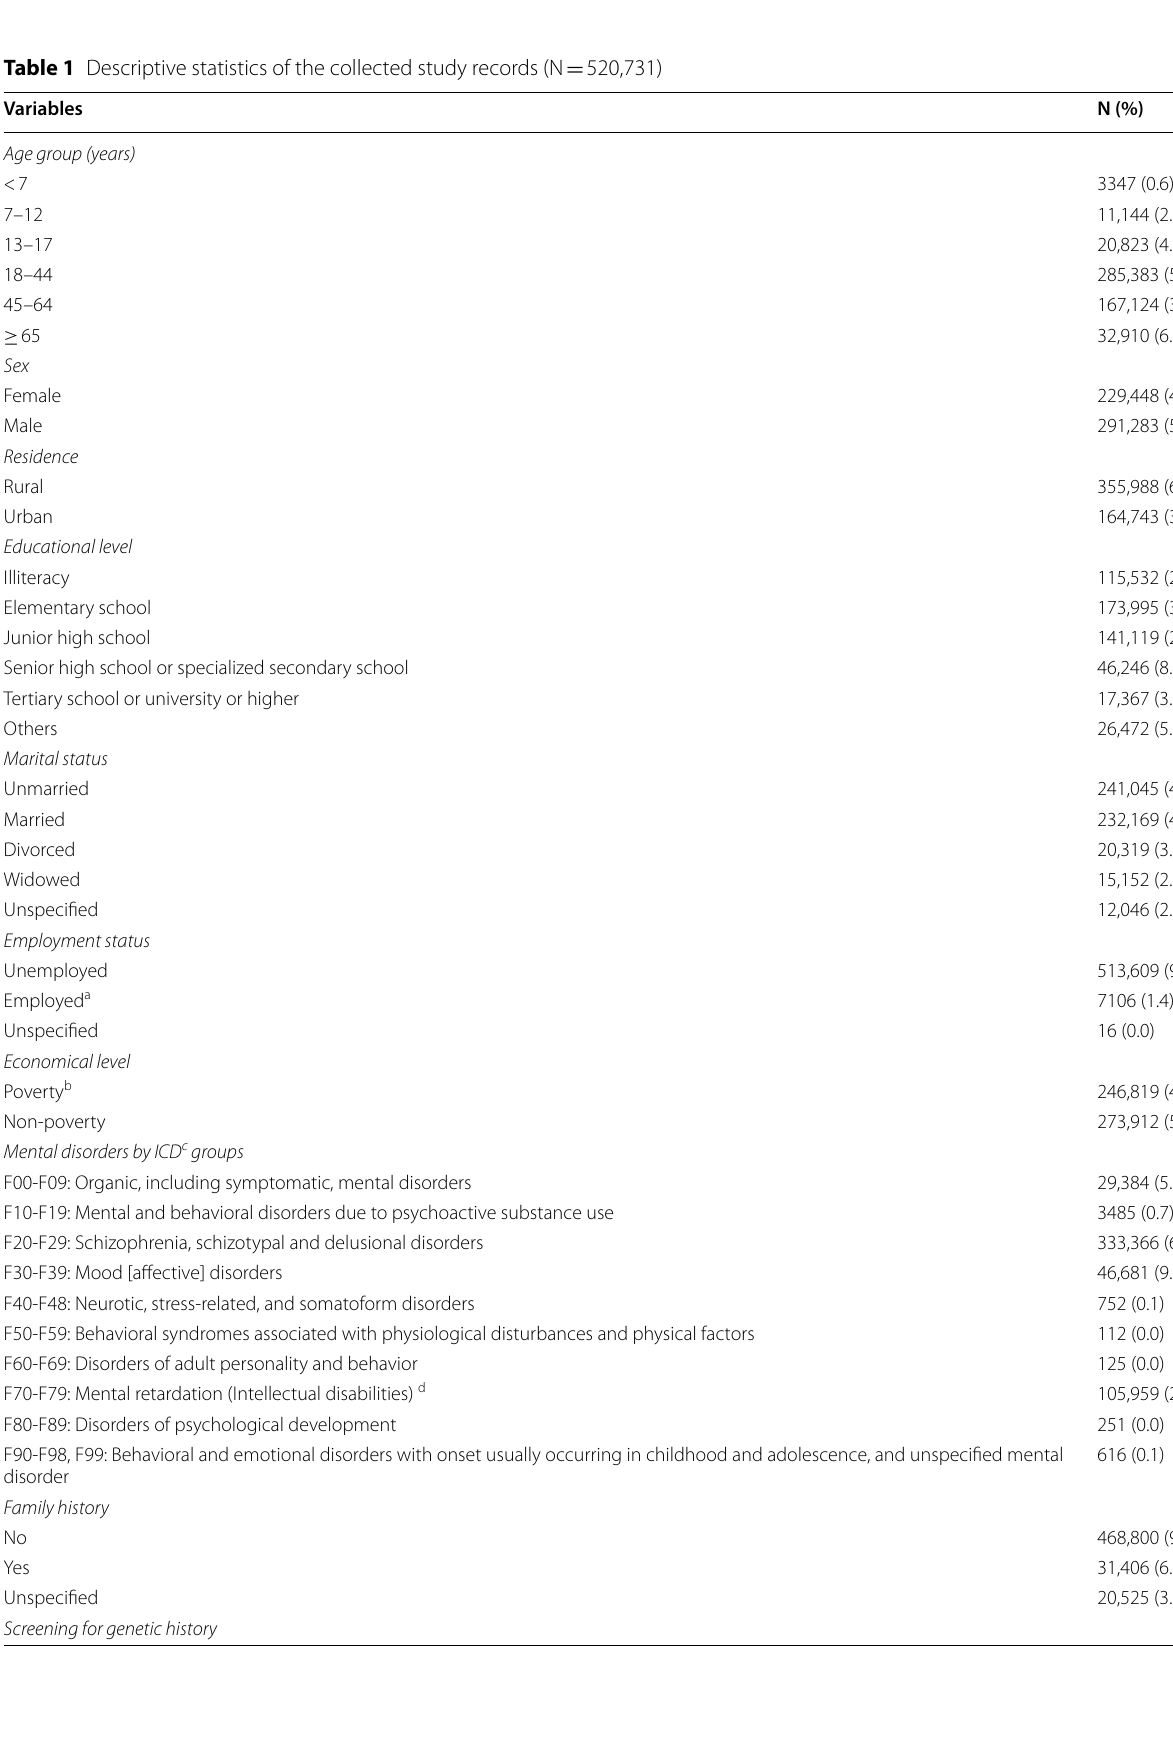
Table 1 Descriptive statistics of the collected study records (N